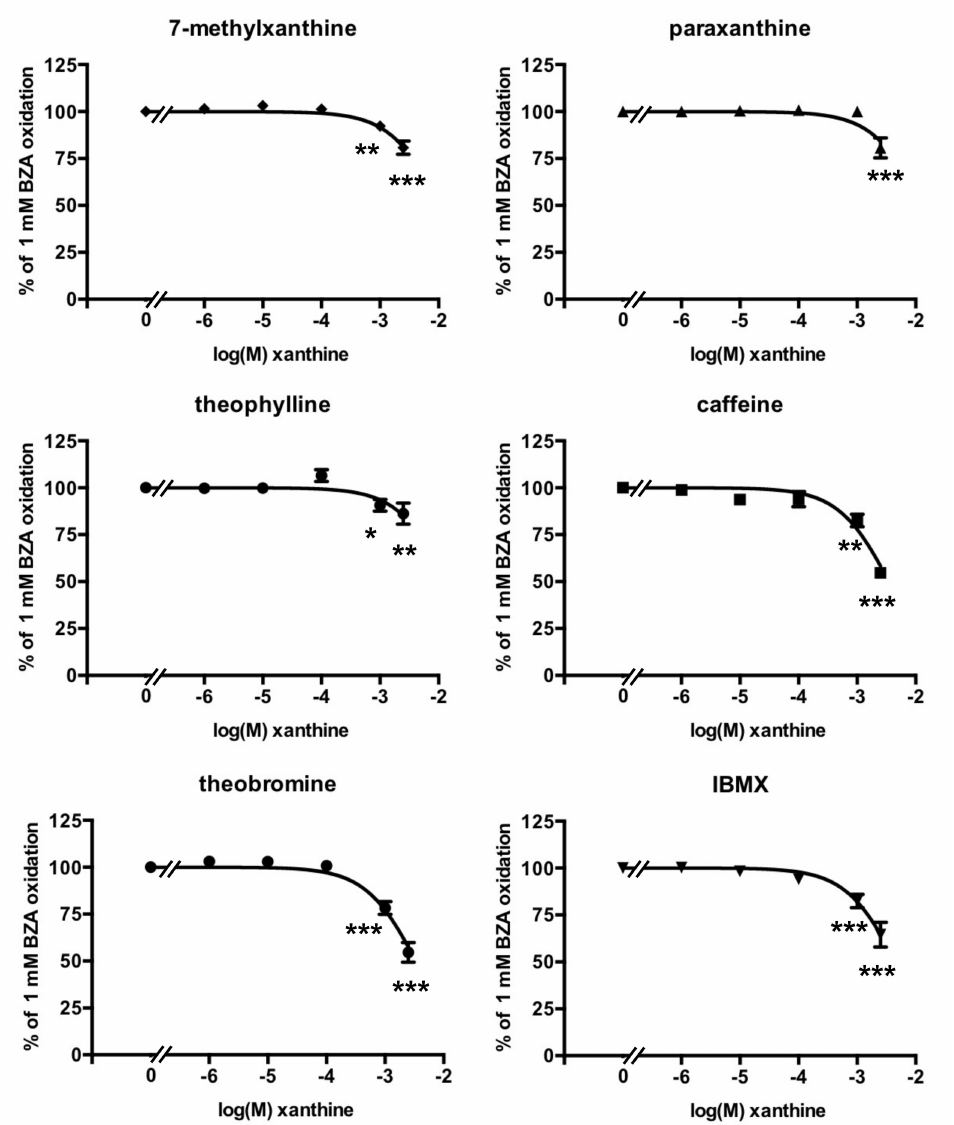
Figure 2. Dose-dependent inhibition of benzylamine oxidation by methylxanthines. The control consisted of a standard assay of PrAO-dependent oxidation of 1 mM benzylamine (BZA), performed in triplicate for each of the 27 individual tissue samples, and set at 100%. Mean ± SEM of the number of observations indicated for each agent, added over a concentration range from 1 µ M to 2.5 mM: 7-methylxanthine: 8–20; Paraxanthine: 8–10; Theophylline: 8–20; Ca ff eine: 8–24; Theobromine: 8–20; IBMX: 8–14. The di ff erences from control (plotted as 0 on the X-axis) at: * p < 0.05; ** p < 0.01; *** p